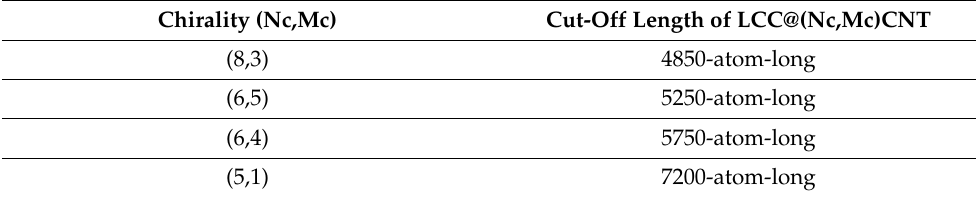
Table 4. A prediction of the LCC lengths in different carbyne@nanotubes at 300 K.